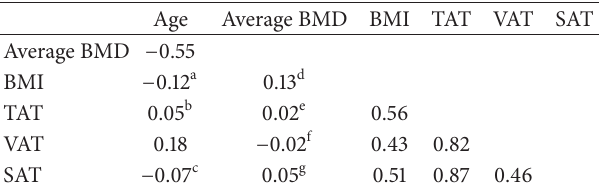
Table 3: Correlations ( r ) between adiposity, age, BMI, and BMD in group aged ≥ 55 years.